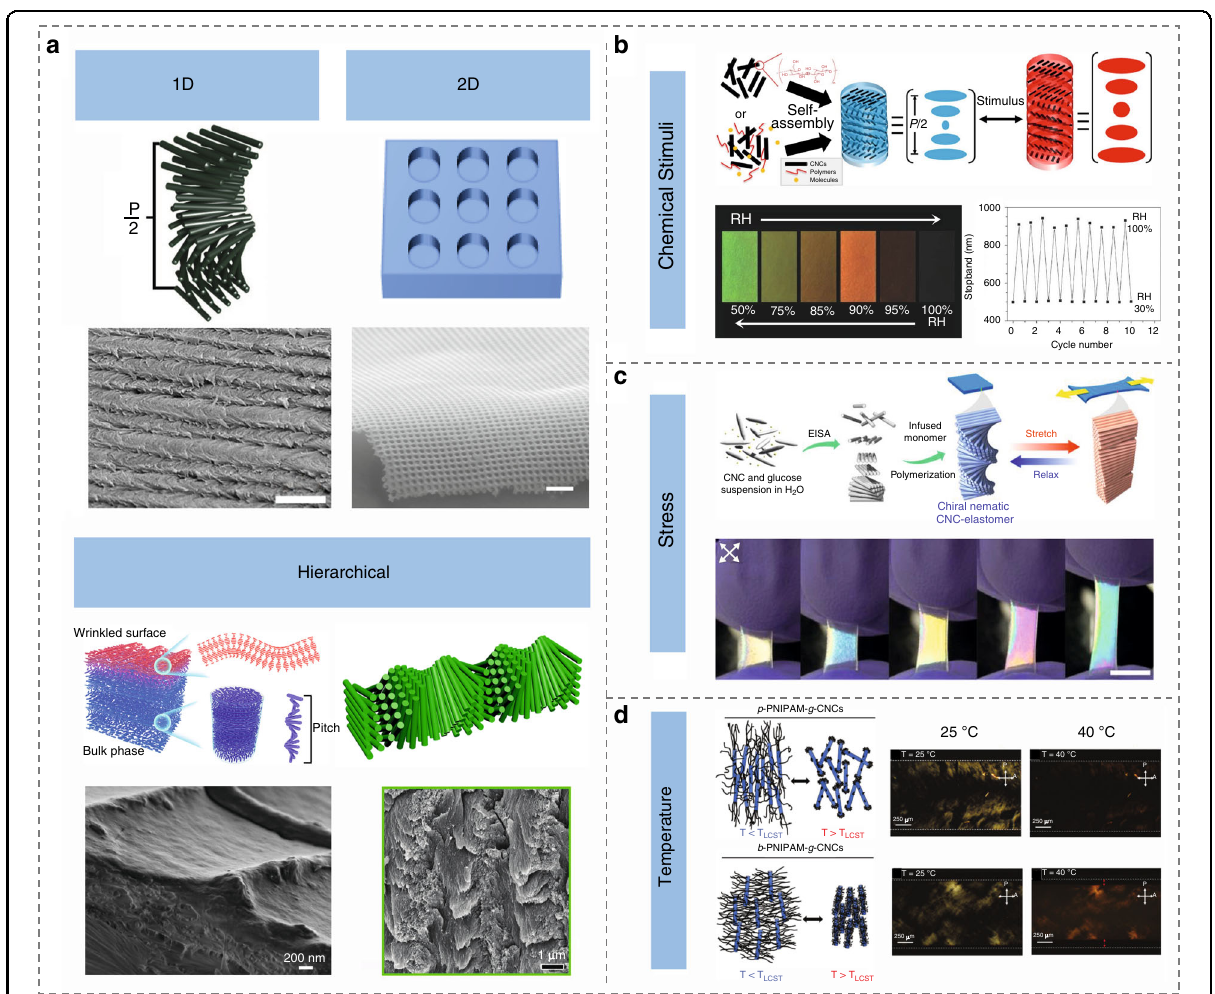
Fig. 9 Cellulose-based representative photonic structures and the corresponding stimulus responsiveness. a Schematics (top rows) and images (bottom rows) of representative photonic architectures 163,170 – 172 . Images reproduced with permissions: 1D-helicoidal structure 163 , Wiley-VCH; 2D-grating structure 170 , Springer Nature: Nature Photonics; Hierarchical chiral nematic structure: left 171 , Elsevier; right 172 , Wiley-VCH. b Structure and structural color changes of CNCs under chemical and humidity stimulations 155,175 . Adapted with permission from ref. 155 . Copyright 2020 American Chemical Society. Reproduced from ref. 175 , with permission from Wiley-VCH. c Schematics and photographs showing the color changes of the CNC- elastomer composite under stretching 183 . Reproduced from ref. 183 , with permission from Springer Nature: Nature Communications. d Temperature- responsive behavior and polarized optical microscopy images of patchy PNIPAM-grafted CNCs and “ brush ” PNIPAM-modi fi ed CNCs 192 . Reproduced from ref. 192 , with permission from